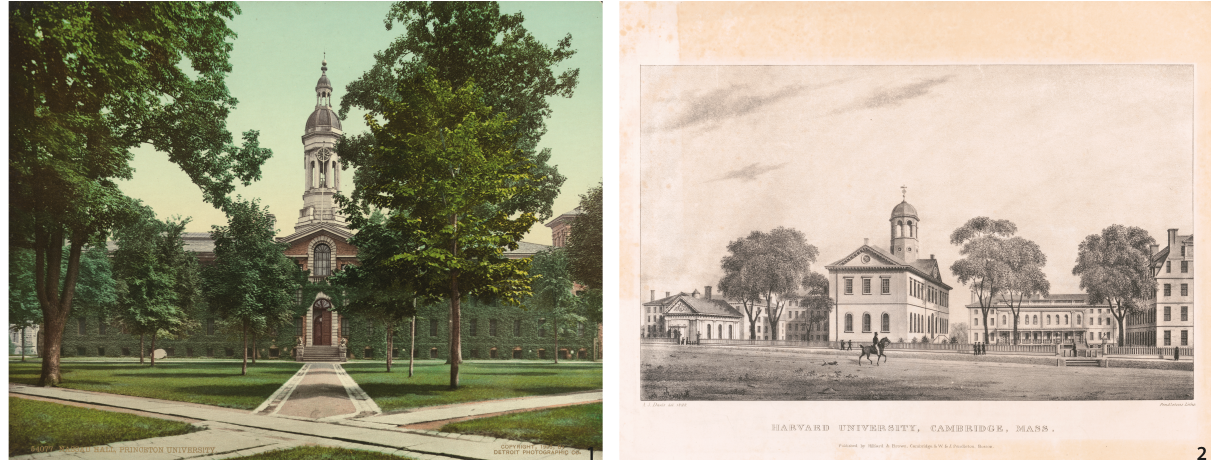
Figure 1 Nassau Hall and Front Campus, ca. 1900, Princeton University, Princeton, New Jersey (Source: US Library of Congress, Washington, DC) Figure 2 Harvard Yard, Harvard University, ca. 1850, Cambridge, Massachusetts (Source: US Library of Congress, Washington, DC).